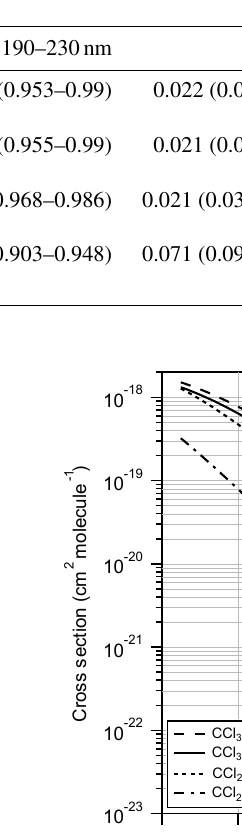
Table 4. Fractional losses and ranges (in parentheses) for CCl 2 FCCl 2 F (CFC-112), CCl 3 CClF 2 (CFC-112a), CCl 3 CF 3 (CFC-113a), and CCl 2 FCF 3 (CFC-114a) calculated using the GSFC 2-D model and the UV absorption spectra and estimated Lyman- α cross sections reported in this work.